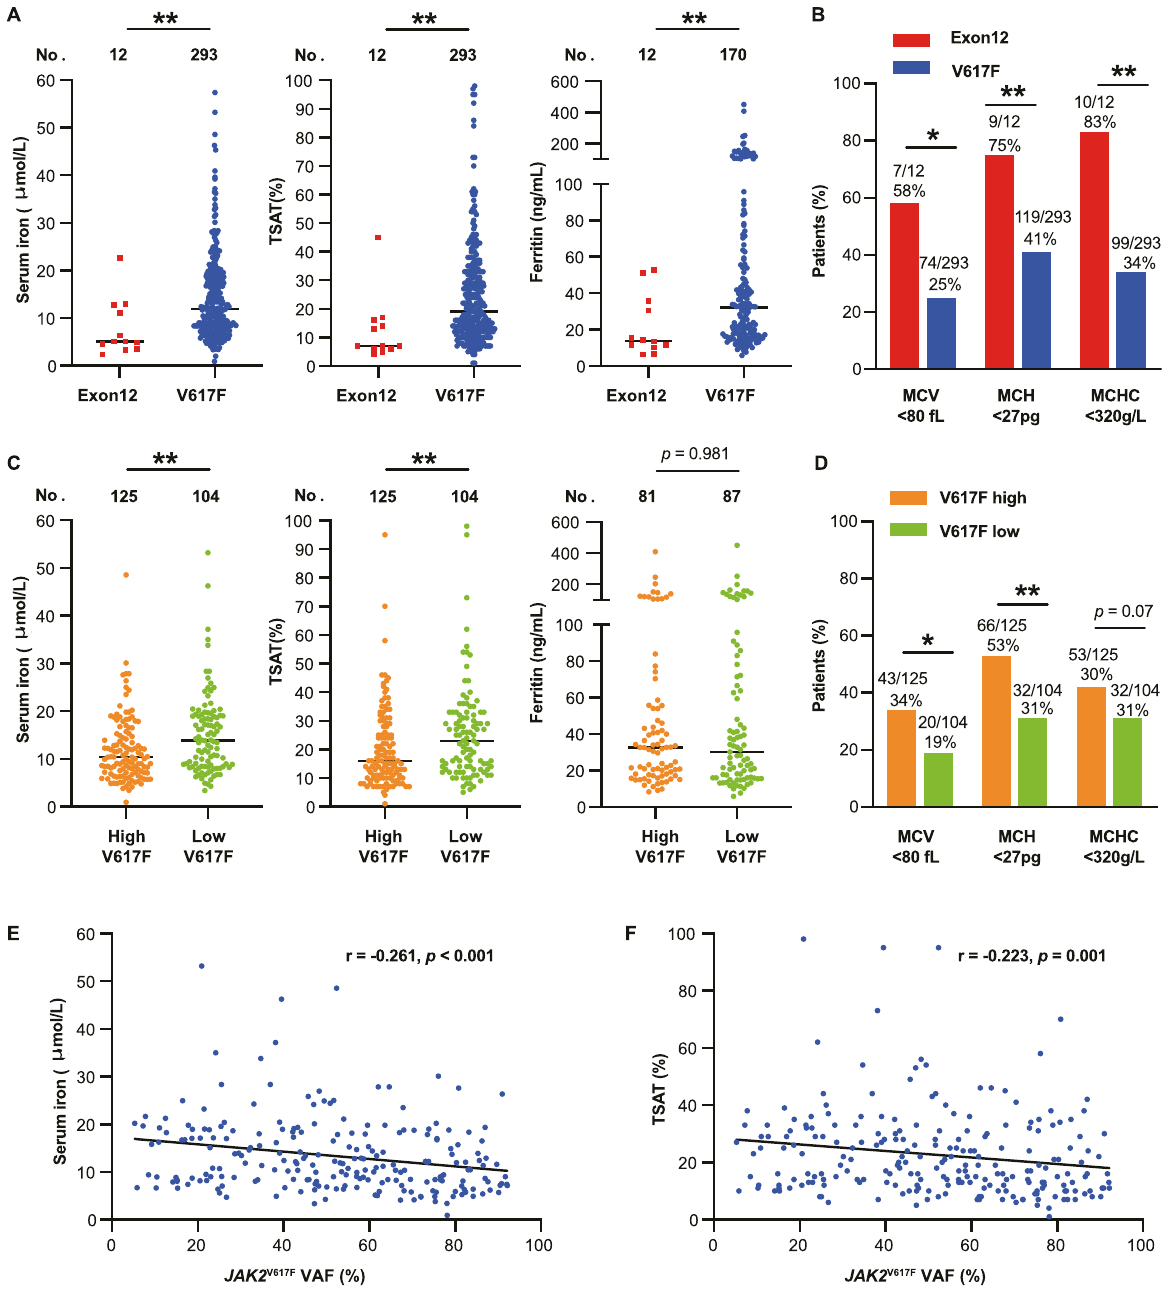
Fig. 1 The relationship between iron de fi ciency and JAK2 mutations in PV patients. A Serum iron, TSAT, and ferritin were signi fi cantly lower in JAK2 exon12 mutated patients than in JAK2 V617F mutated patients. B Declined MCV, MCH, MCHC was more frequent in JAK2 exon12 mutated patients compared with JAK2 V617F mutated patients. C Serum iron, TSAT were signi fi cantly lower in patients with low JAK2 V617F VAF (<50%) than in patients with high JAK2 V617F VAF ( ≥ 50%) among JAK2 V617F mutated patients, but the ferritins were comparable between two these two cohorts. D Declined MCV, MCH, MCHC was more frequent in subjects with high JAK2 V617F VAFs compared with low JAK2 V617F VAFs. E and F JAK2 V617F VAF negatively correlated with serum iron and TAST in JAK2 V617F mutated patients. PV polycythemia vera, TSAT transferrin saturation, MCV mean corpuscular volume, MCH mean corpuscular hemoglobin, MCHC mean corpuscular hemoglobin concentration, VAF variant allele frequency. * p < 0.05; ** p < 0.01; *** p < 0.001.